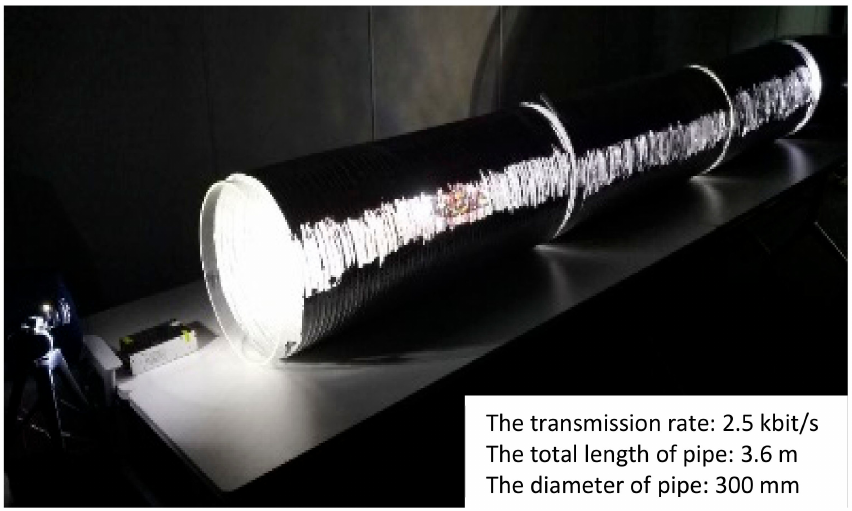
Figure 17. Coordinated movement of RCS in the pipe with steel cover.